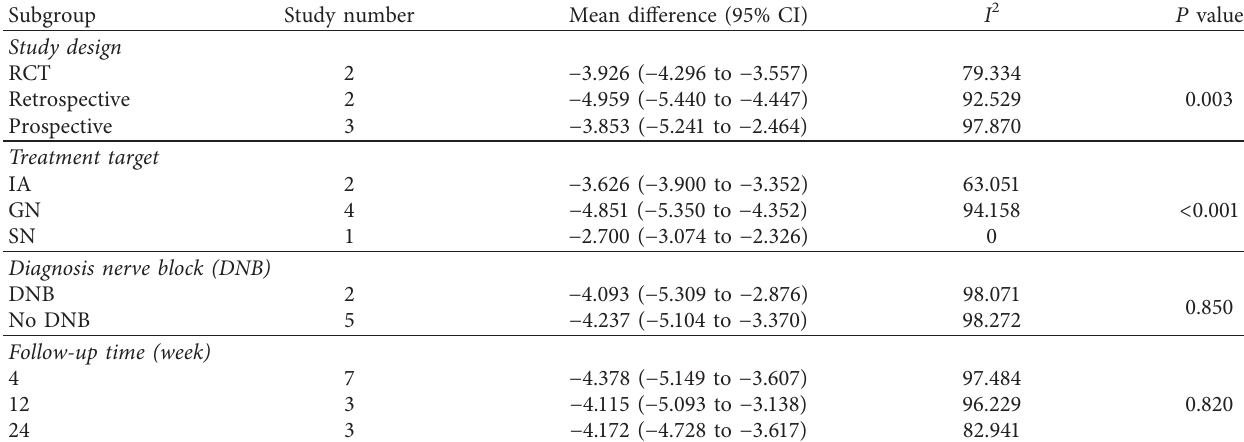
Table 5: The potential sources of heterogeneity on pain intensity by subgroup analysis.